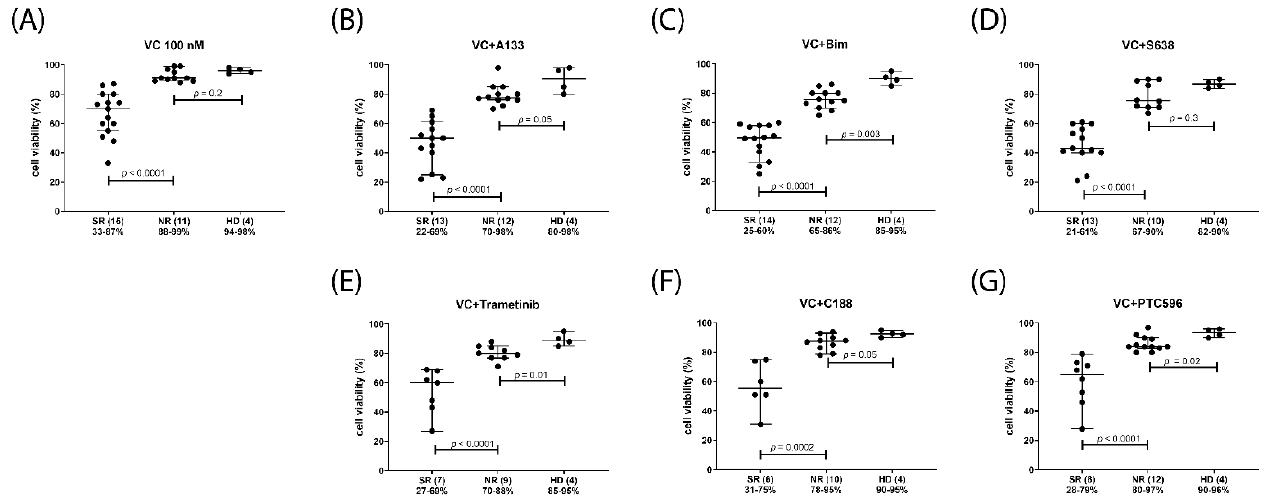
Figure 5. Hematological cells in vitro response to venetoclax and various combination treatments. Cell viability was determined in mononuclear cells isolated from AML patients or healthy donor (HD) peripheral blood or bone marrow after 20 h treatment. The patient samples were sorted into two equally sized groups, one with major (strong) response (SR) and one with minor (normal) response (NR). Number of samples in each group are indicated in parentheses. Cells were treated in vitro with 100 nM venetoclax (VC) only ( A ), 100 nM venetoclax in combination with 1 µ M A1331825 ( B ), 1 µ M bimiralisib ( C ), 100 nM S63845 ( D ), 100 nM trametinib ( E ), 1 µ M C-188-9 ( F ), or 200 nM PTC596 ( G ). Significance of differences in median values was calculated by Mann–Whitney test.